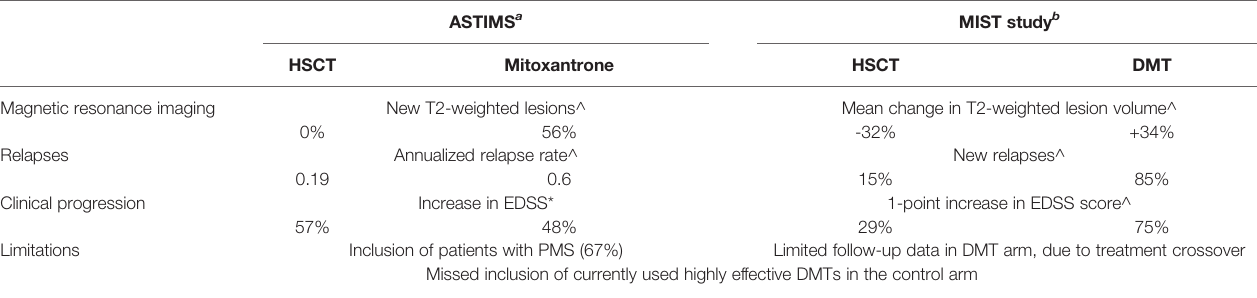
TABLE 1 | Selected clinical outcomes from the two randomized controlled trials of HSCT vs.